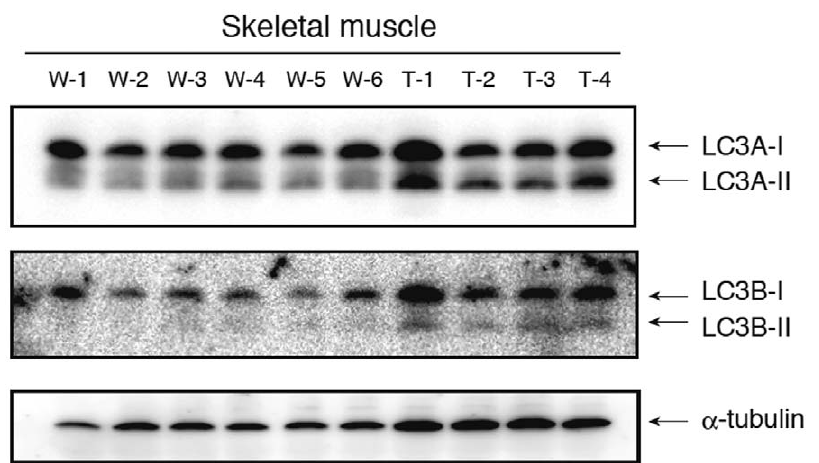
Figure 5. Autophagy is induced in the skeletal muscles of the NF90 Tg mice. Immunoblot analysis of LC3A and LC3B in tissue extractions of skeletal muscles of WT (n=6) and NF90 Tg mice (line TG1) (n=4). Anti- a -tubulin was used as loading control. W-1 to -6, WT; T-1 to -4, NF90 Tg mice (line TG1).